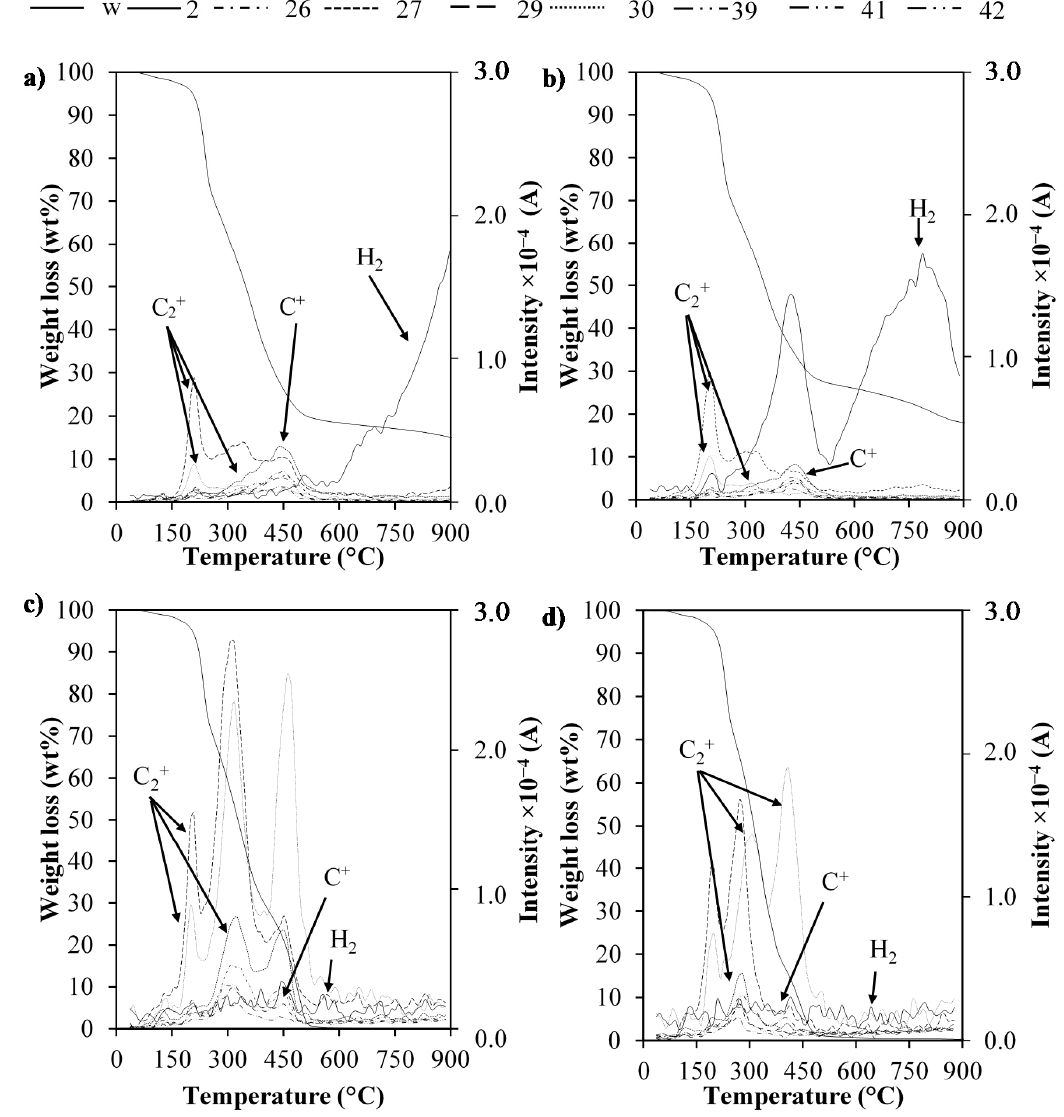
Figure 6. Profiles of the ions m/z = 2, 26, 27, 27, 29, 30, 39, 41 y 42 by TG-MS at 30 °C min − 1 , during ( a , b ) pyrolysis and ( c , d ) combustion, for ( a , c ) biomass y ( b , d ) biomass/catalyst 1:1. Catalyst: Rh-Pt/CeO 2 -SiO 2 .